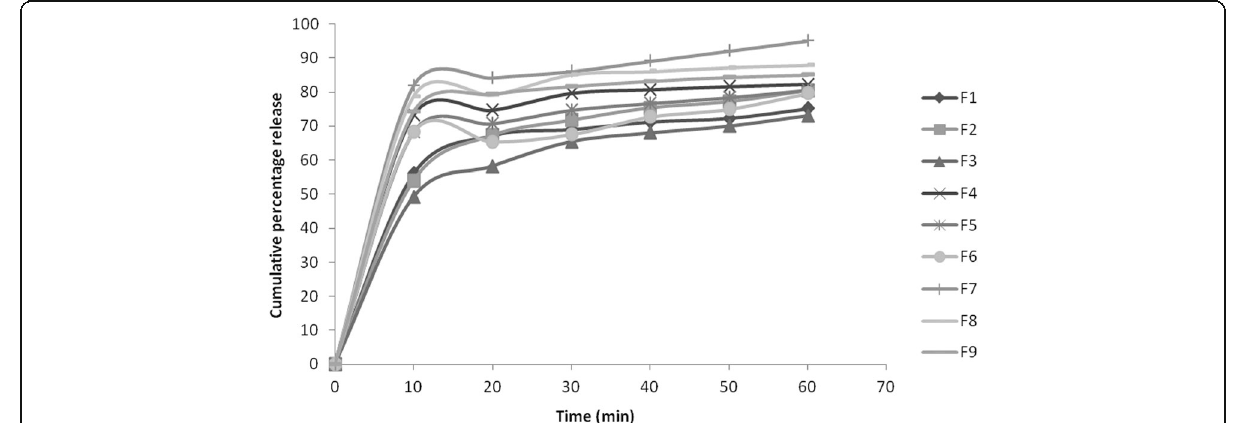
Fig. 4 Dissolution profile of factorial